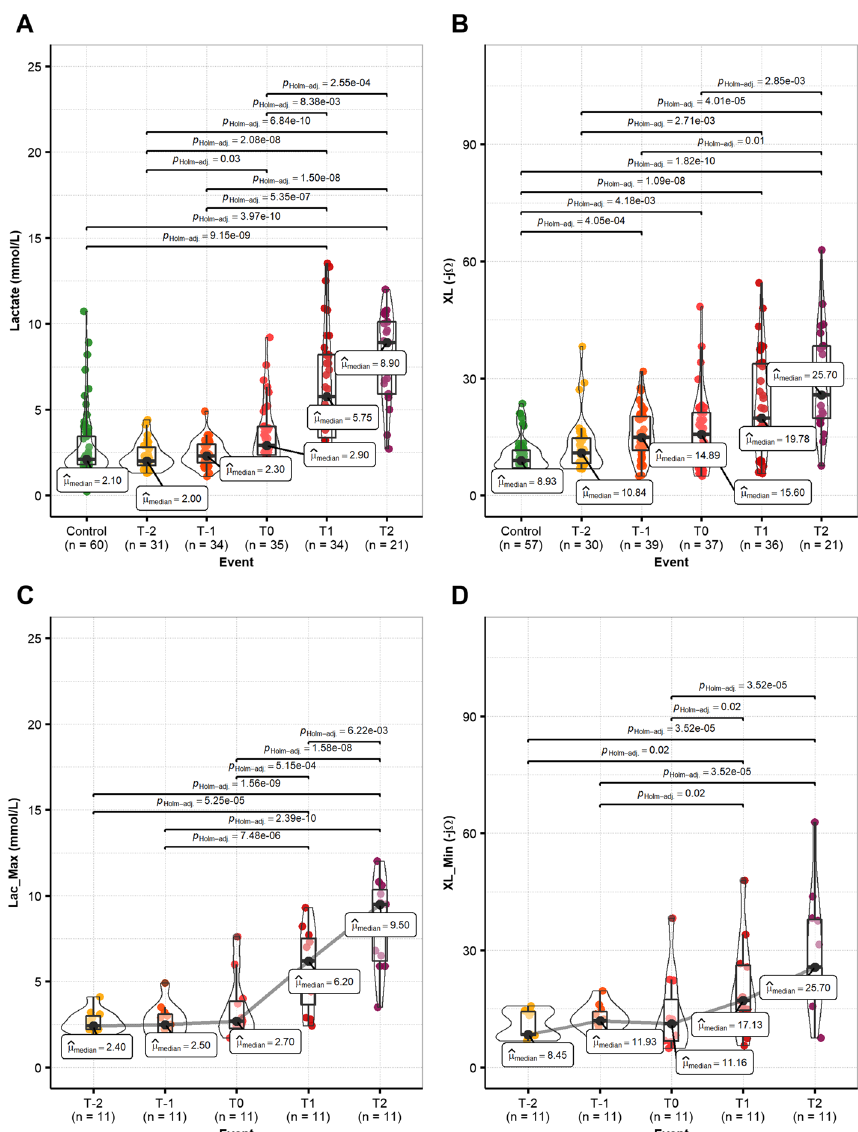
Fig. 2 Comparison of Lactate ( A ) and XL ( B ) between the control group (CG) and the shock group (SG). Comparison of the SG for paired data for maximum lactate values per subject per event (Lac_Max) ( C ), and minimum XL values per subject per event (XL_Min) ( D ). Events by shock criterion (MAP h before shock; T‑1: 1 h before shock; T0: shock; T1: 1 h after shock; T2: 2 h after shock. Significant differences between groups are marked as bars with their corresponding p values. Post hoc Dunn’s all‑pairs test for Kruskal–Wallis rank‑sum test and post hoc Durbin’s all‑pairs test for Friedman rank‑sum test. Significant p values < 0.05. Full Post hoc analysis per variable and time point is available in Additional file 5: Tables